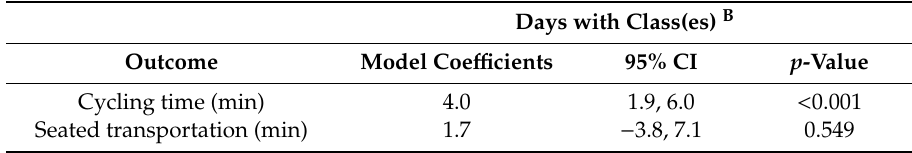
Table 4. Association between days with classes and students’ method of transportation.